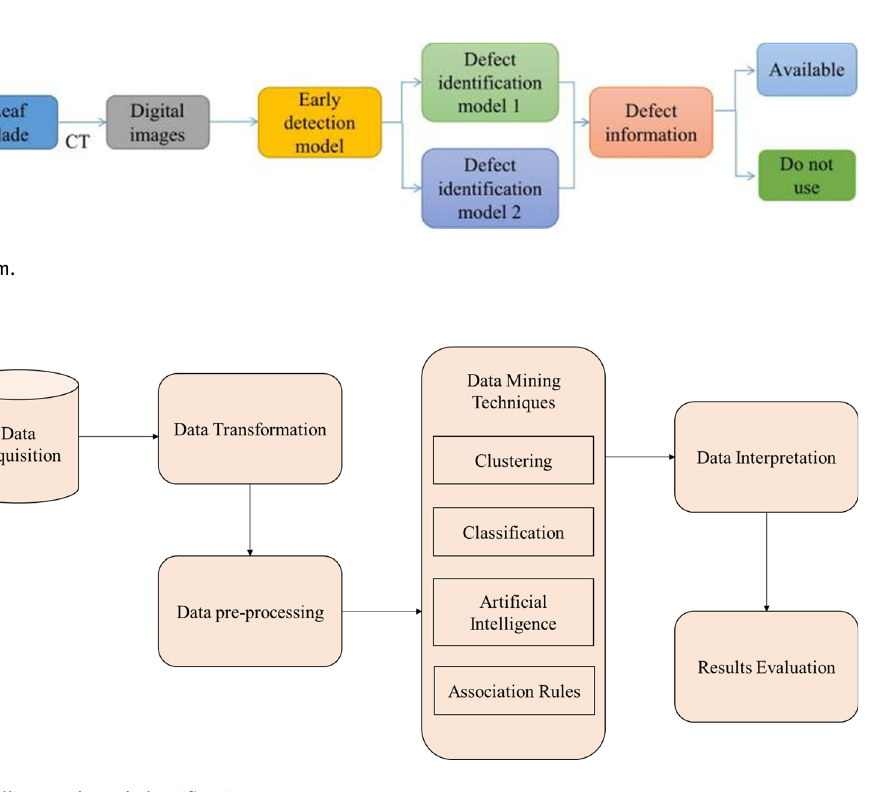
Figure 2: Arti fi cial intelligence - based classi fi cation